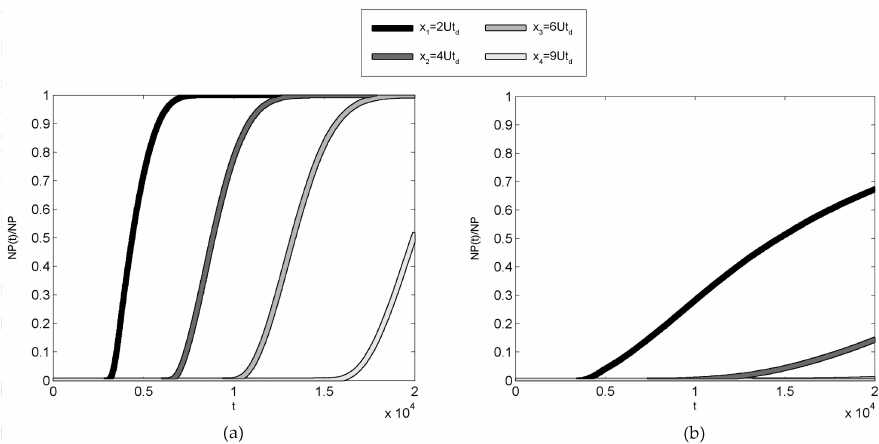
Figure 5. Breakthrough curves for R2. ( a ) Uniform mixing; ( b ) Non-uniform